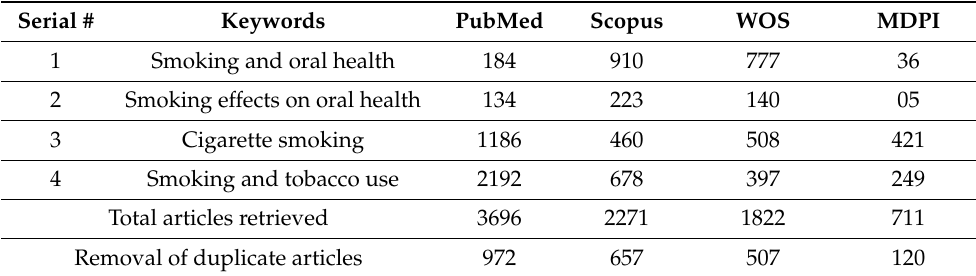
Table 1. Search strategy for study-related articles.